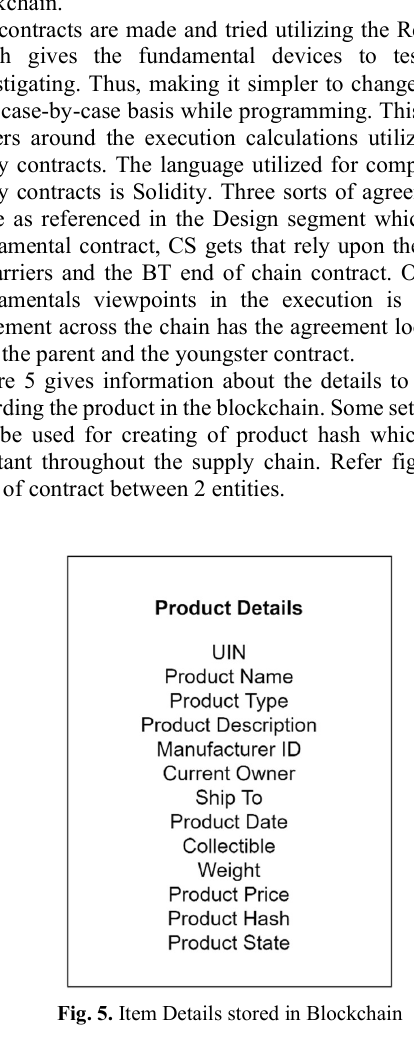
Fig 2: Transfer of ownership and transaction details are stored in blockchain